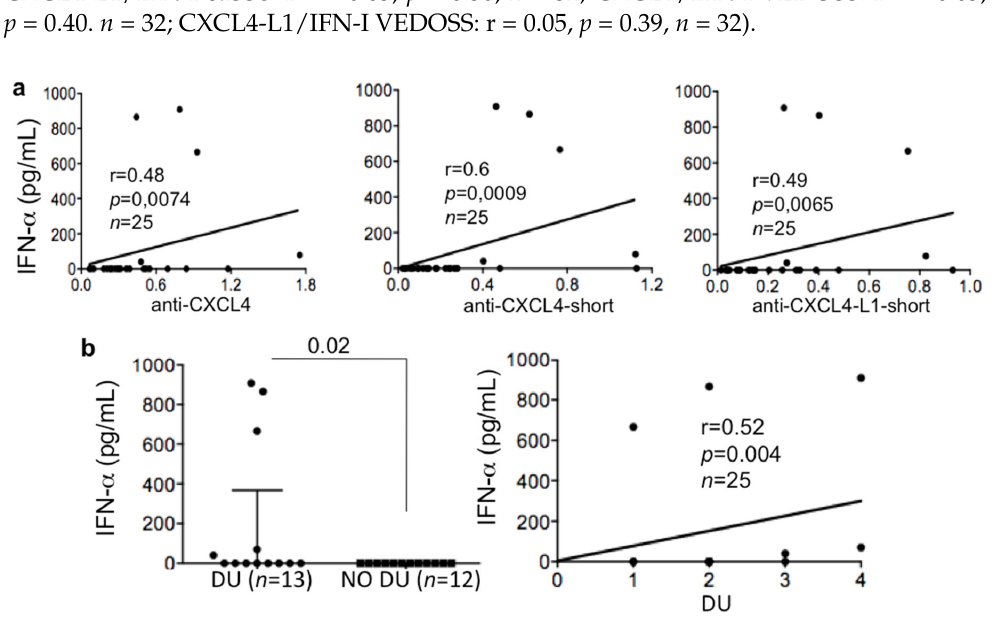
Figure 3. Anti-CXCL4/CXCL4-L1 antibodies correlate with IFN-a in lsSSc. ( a ) Amounts of IFN-a in sera or plasma, pg/mL, measured by ELISA, plotted against anti-CXCL4 (entire CXCL4) antibodies or antibodies directed to the COOH-part of CXCL4 (anti-CXCL4-short) or anti-CXCL4-L1 (anti- CXCL4-L1-short) expressed as OD. ( b , left panel) LsSSc patients were divided in two groups, one presenting DU and the other without DU (NO DU). IFN-a was measured in both groups by ELISA as in ( a ). Horizontal bars are the medians plus interquartile range; p value by Mann–Whitney’s test. ( b , right panel) Level of plasma IFN-a plotted against number of DU in lsSSc patients. Spearman “r” coefficient, p values and sample size, N, are